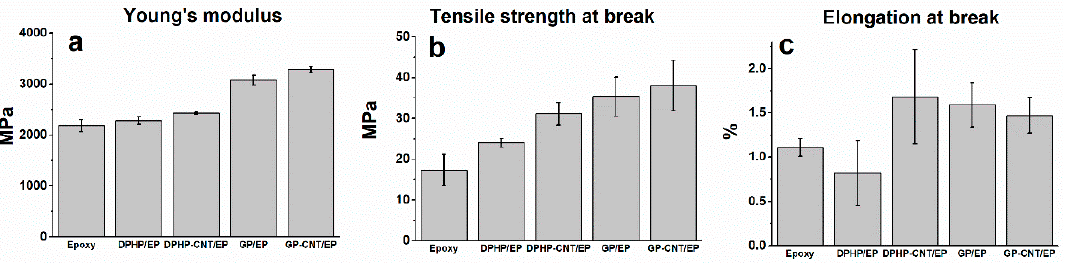
Figure 6. ( a ) Young’s modulus; ( b ) tensile strength and ( c ) elongation at break of the Epoxy, DPHP/EP, DPHP-CNT/EP, GP/EP, and GP-CNT/EP nanocomposites.